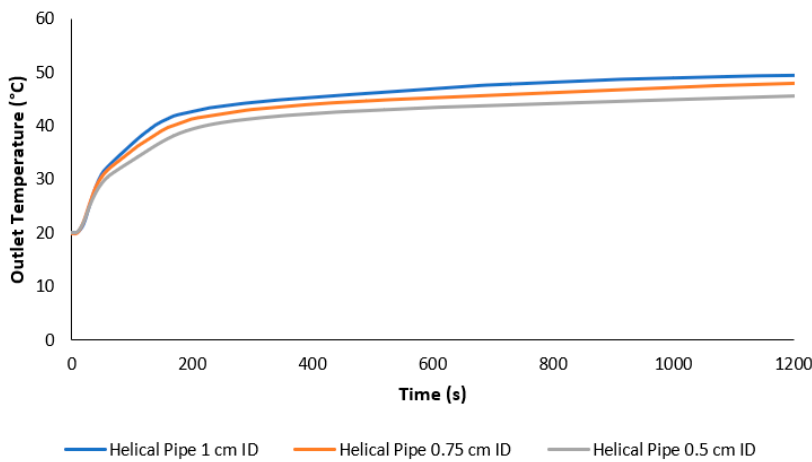
Figure 15. Heat transfer rate vs. time for the helical pipe configuration with various IDs.